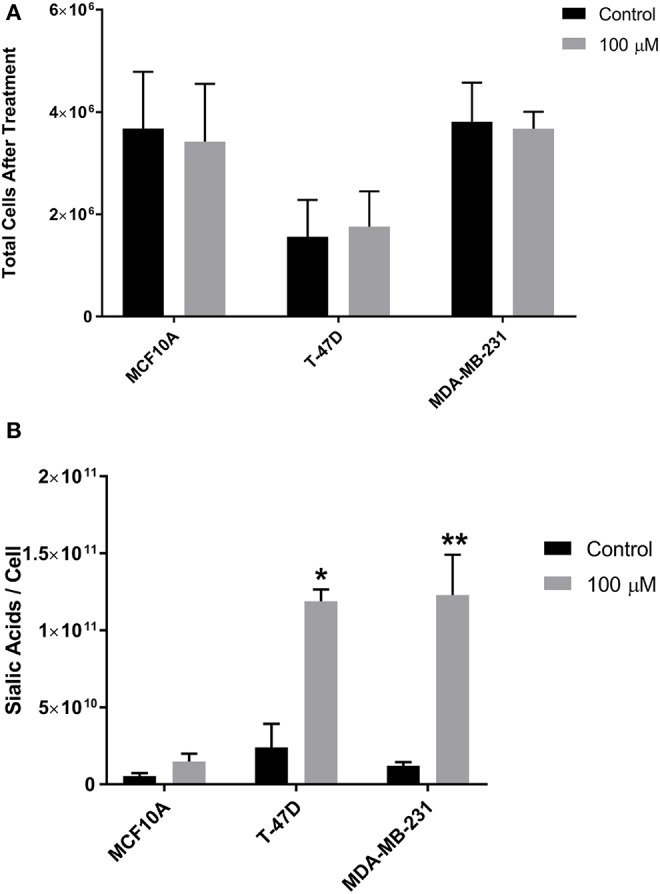
Growth rate (cell viability) and sialic acid production. (A) Cells were incubated with 1,3,4-O-Bu3ManNAc (or with solvent vehicle as a control) and counted after 48 h. (B) Aliquots of the cells were subject to the periodate resorcinol assay to determine sialic acid levels. Periodate-resorcinol assays were performed in triplicate. Significance was assessed using Student's t- test, **p < 0.01, *p < 0.05. Error bars indicate ± SEM.